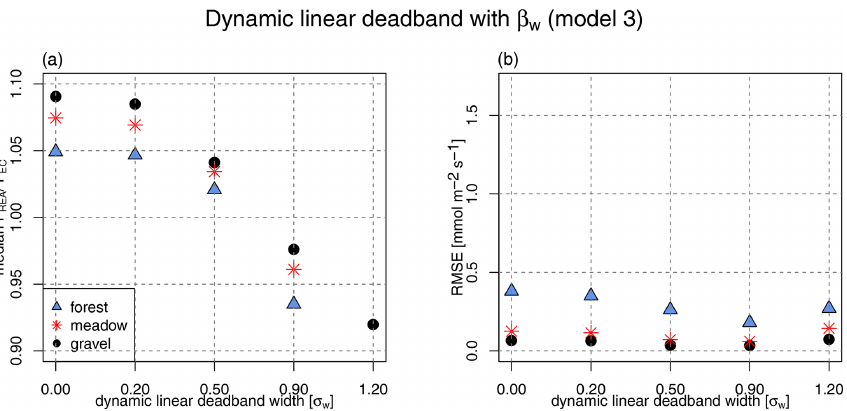
Figure 7. Errors as a function of dynamic linear deadband width. The x axis is the scaling factor a multiplied by the vertical wind standard deviation σ w in Eq. (9) to define the deadband threshold. (a) Median F REA / F EC ratio (latent heat flux simulated using the REA approach described in Baker, 2000) for each of the simulated dynamic deadband widths; (b) RMSE for each of the simulated dynamic deadband